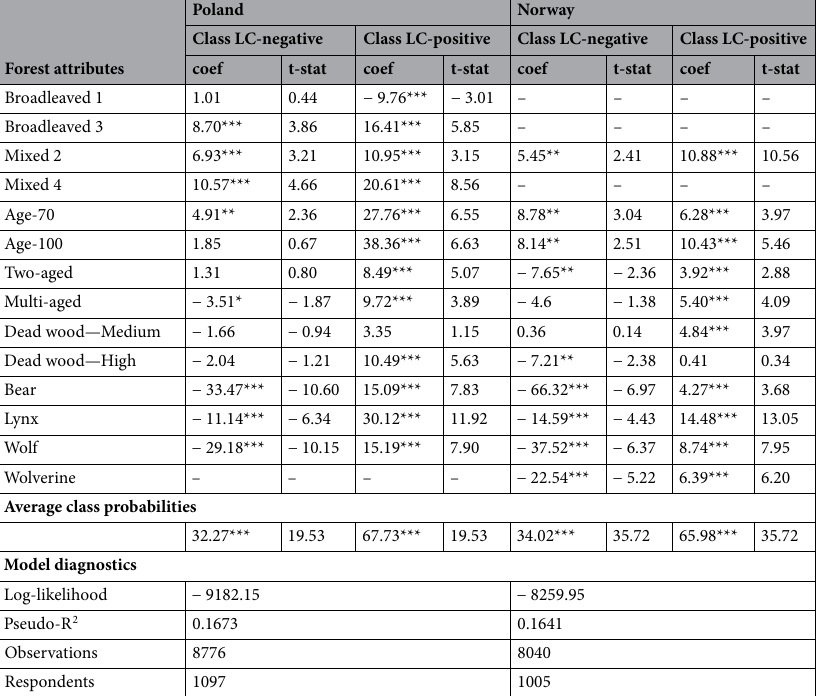
Table 4. Output of the Latent Class Multinomial Logit model assessing the public preference for forest attributes and large carnivore presence, expressed as willingness-to-travel, in Poland and Norway for the two classes of respondents (LC-positive and LC-negative). The levels of significance are as follows: *0.1, **0.05,